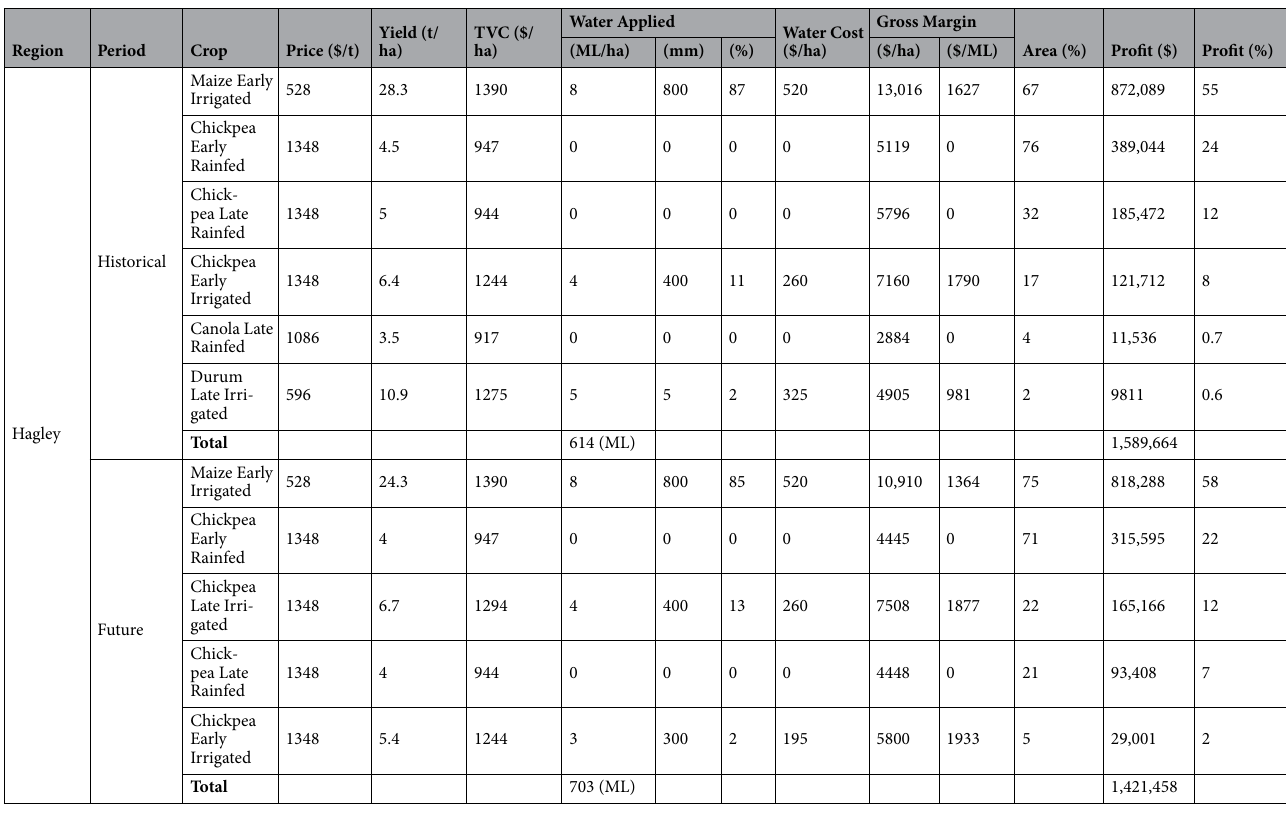
Table 7. Farming systems and crop planting areas that maximise whole farm profit under historical and future climates. Results are shown for a range of representative environments in Australian irrigated cropping regions under historical (H = 1985–2021) and future (F = 2070–2089) climatic conditions. TVC = total variable cost, percentage column under water applied denote annual water allocation used for that crop to attain peak